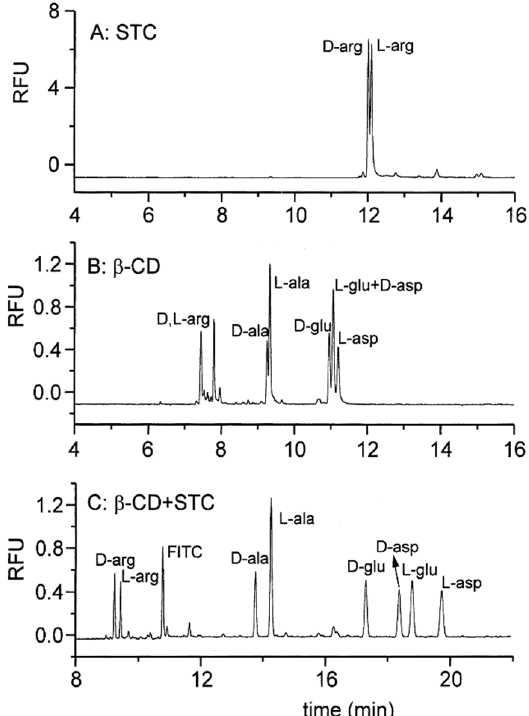
Figure 6. Electrochromatogram of the chiral separation of FITC-derivatized DL-amino acids. Separation conditions: separation media: 80 mM borate buffer (pH 9.3) with 30 mM sodium taurocholate ( A ), 30 mM β -CD ( B ), and 12 mM sodium taurocholate with 8 mM β -CD ( C ). Sample injection: 0.5 psi for 1 s. Voltage: 20 kV. Capillary temperature: 20 °C. Detection: 488 nm ( λ ex ) and 520 nm ( λ em ). Capillary dimension: 57 cm (50 cm effective length) × 50 µm. Reprinted with permission from the authors [58], © 2021 Elsevier.